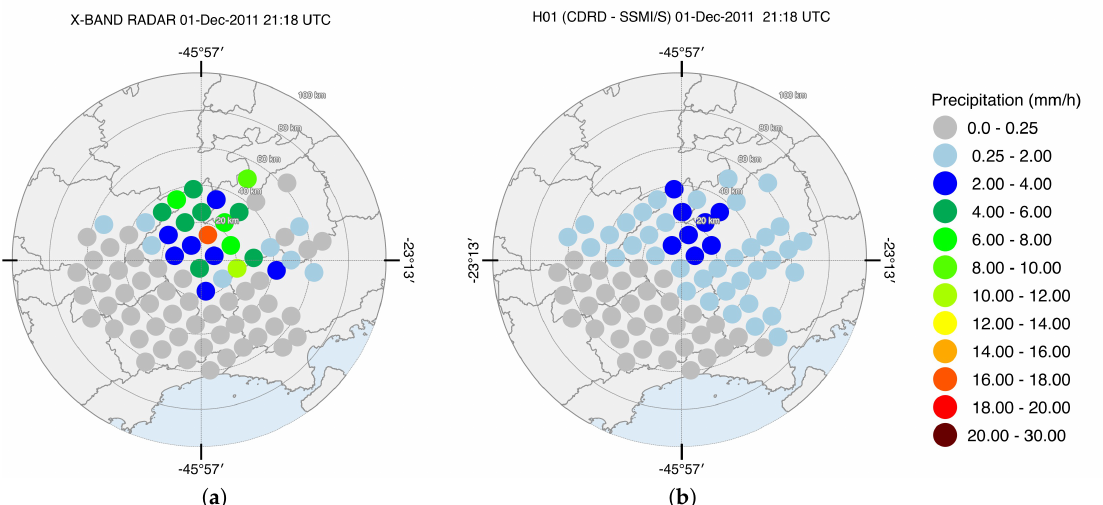
Figure 16. ( a ) Overall radar quality index and ( b ) Rain rate from radar on 1 December 2011 at 21:18 UTC.